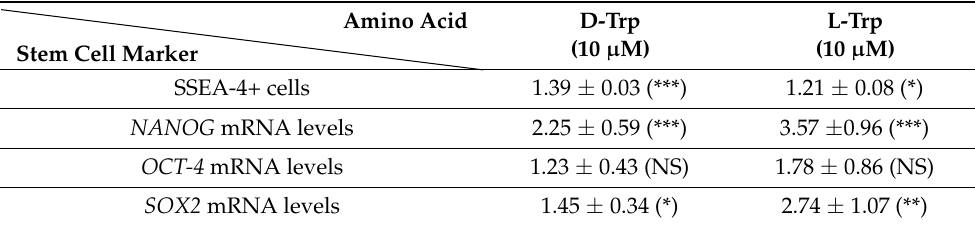
Table 1. Comparison effect of L- and D-tryptophan. Both amino acids induced an increase in the percentage of SSEA-4 positive cells (FCM analysis) and mRNA levels of stem cell markers as NANOG , SOX2 , OCT-4 , compared to the control group. The value is the ratio between treated and control groups. The results are representative of at least three independent experiments. * p < 0.05, ** p < 0.01, *** p < 0.001, ns: non-significant, unpaired t -test. Amino Acid Stem Cell Marker